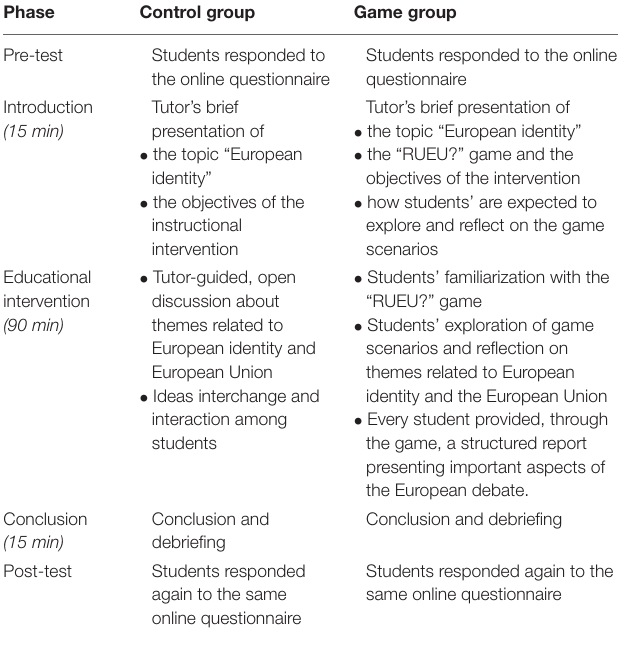
TABLE 1 | Research and intervention